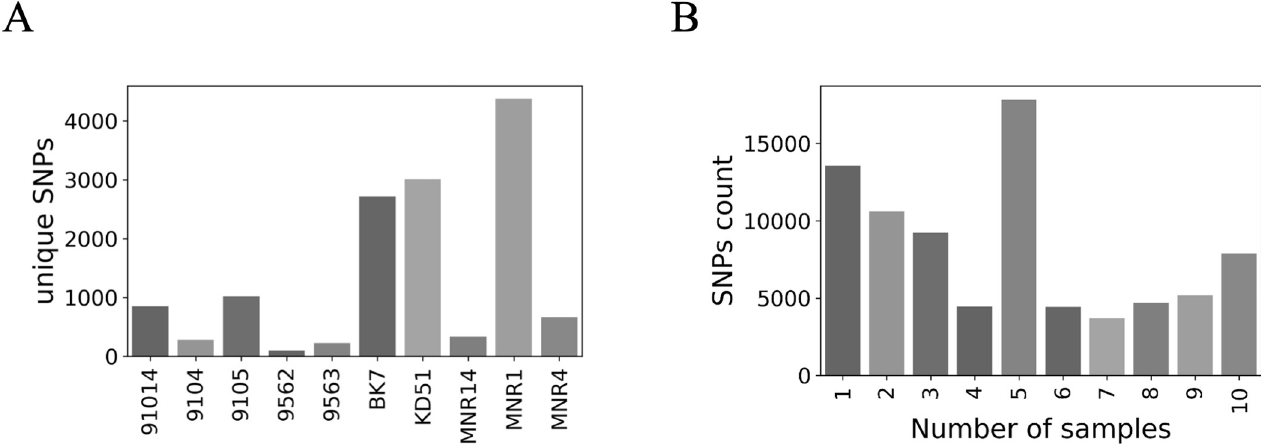
Fig 1. Single nucleotide polymorphisms analysis of Leishmania turanica strains. (A) Strain-specific SNPs. (B) Persistence of SNP in samples. The X axis shows the number of strains sharing SNPs. The shades of gray are only